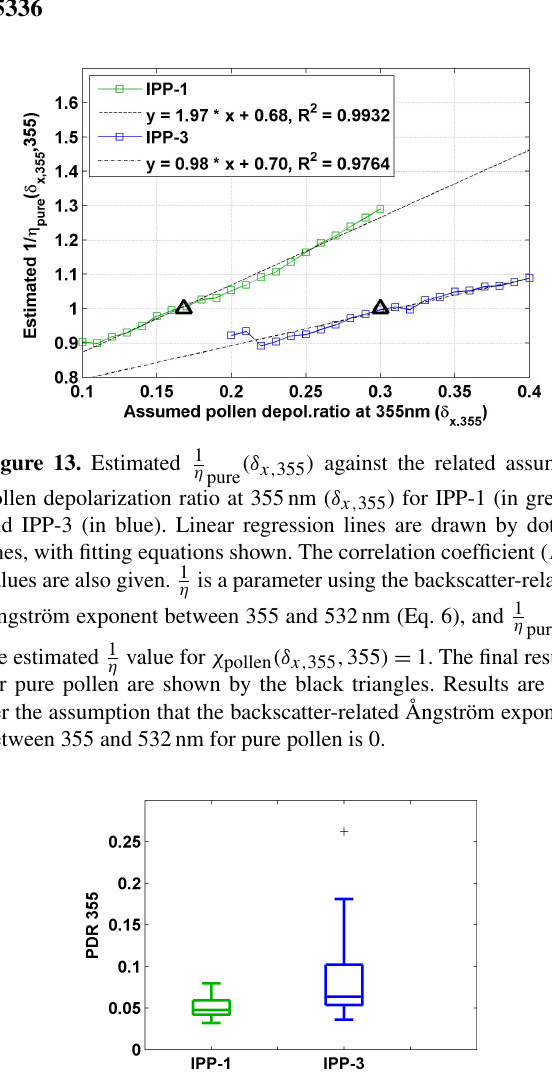
Figure 14. Box plots of estimated particle linear depolarization ra- tio (PDR) at 355nm. Mean values of the detected pollen layer for all IPPs are used. The horizontal line represent the median, the boxes the 25% and 75% percentiles, the whiskers the standard deviation, and the plus signs the outliers. Results are under the assumption that the backscatter-related Ångström exponent between 355 and 532nm for pure pollen is